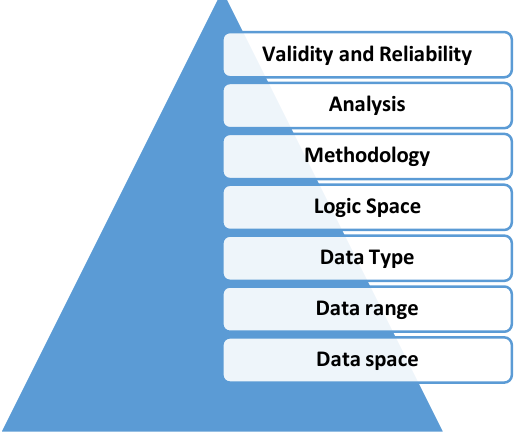
Fig. 4. Data space and data range determines the validity and reliability of any